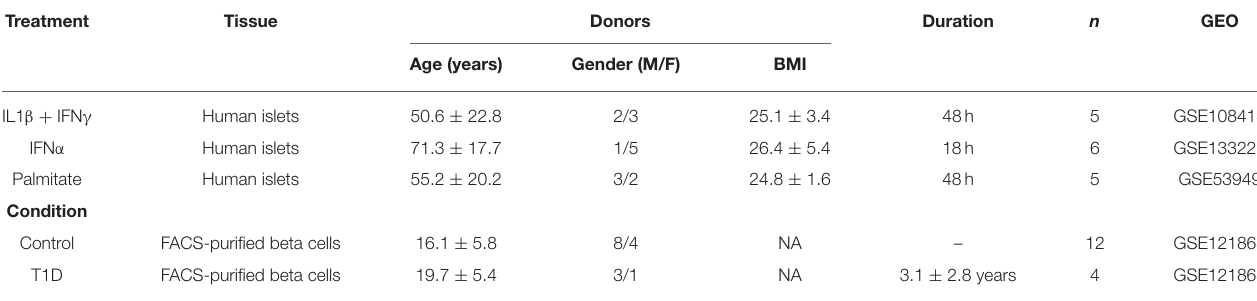
TABLE 1 | Description of the datasets of pancreatic human islets and purified beta cells exposed to different stimuli and conditions presently evaluated.